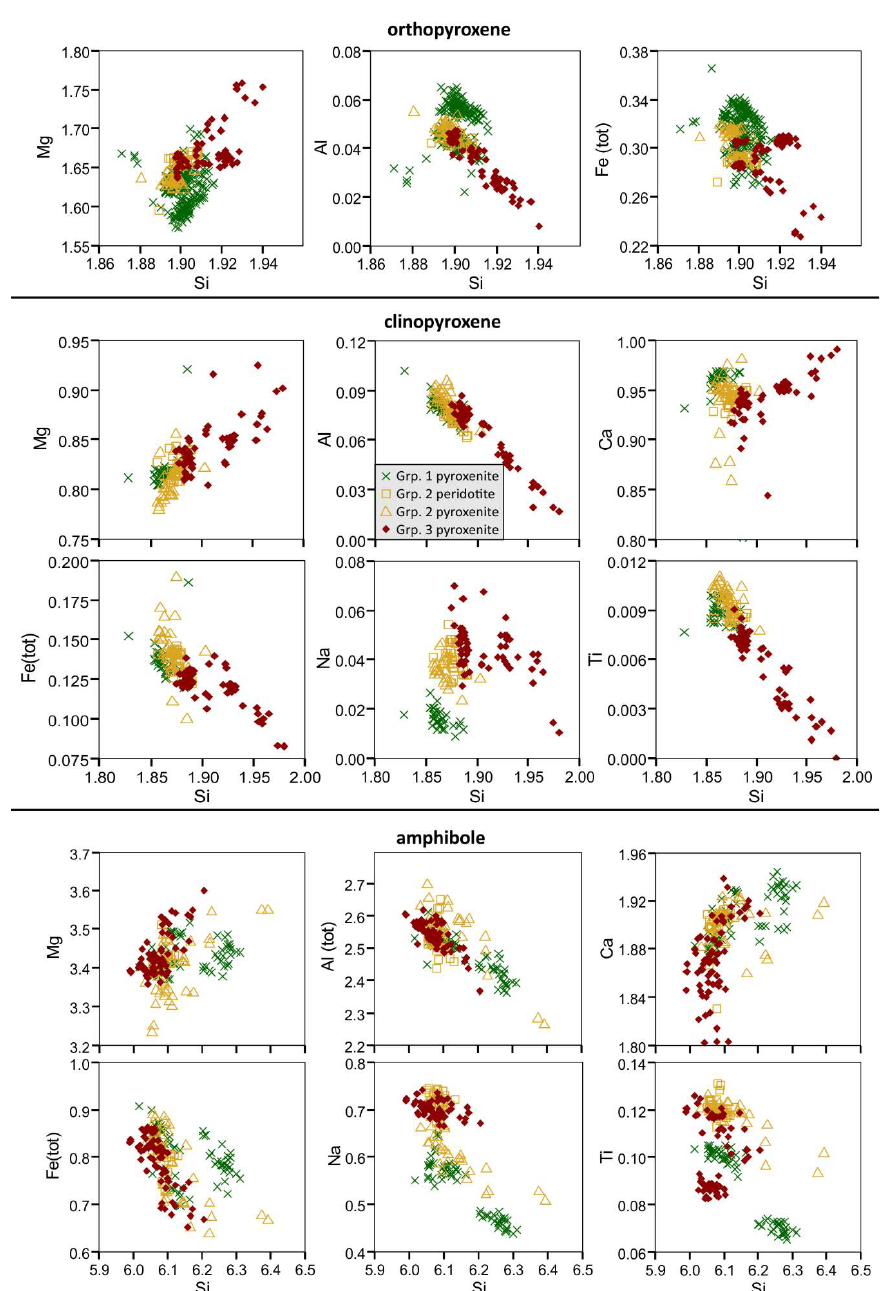
Figure 10. Bivariate plots detailing the major and minor-element compositions of orthopyroxene, clinopyroxene and amphibole. Axes are in atoms per formula unit (apfu). Amphibole analyses were originally published in Guice et al. [45].